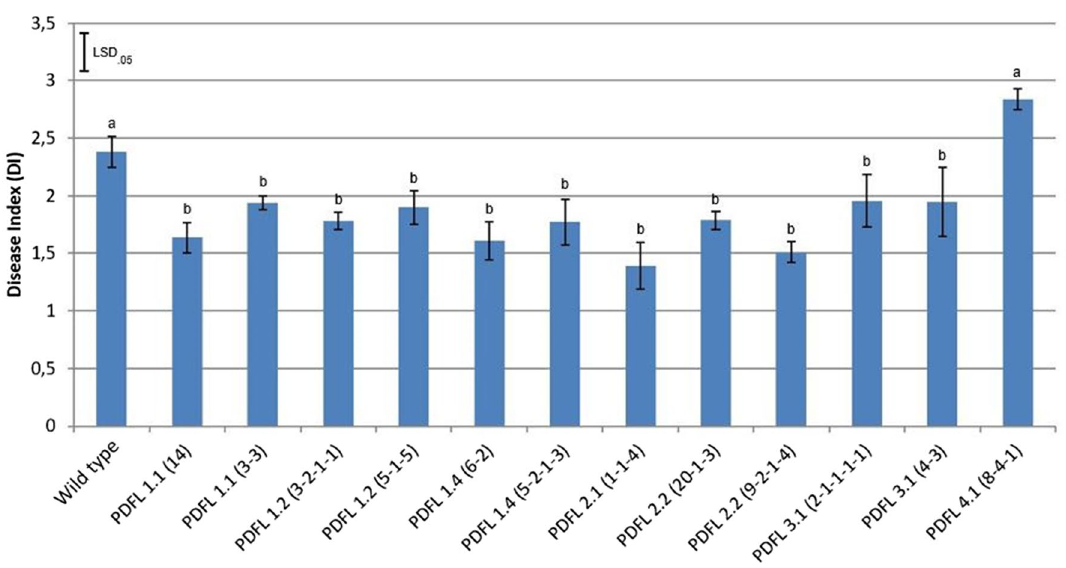
Figure 13. Disease index of PdfL s overexpression lines infected with F. oxysporum f. sp. matthiolae. For each line 4 Petri dishes were infected. Forty cotyledons from each Petri dish were evaluated for calculation of disease index and the mean value from 4 Petri dishes for each line is shown in this graph. Mean data was subjected to analysis of variance (ANOVA). The bars indicate standard error of the mean; the vertical bar represents LSD (p = 0.05) for comparing the mean values. Positive significant differences than wild-type are indicated with a different letter (b) above the